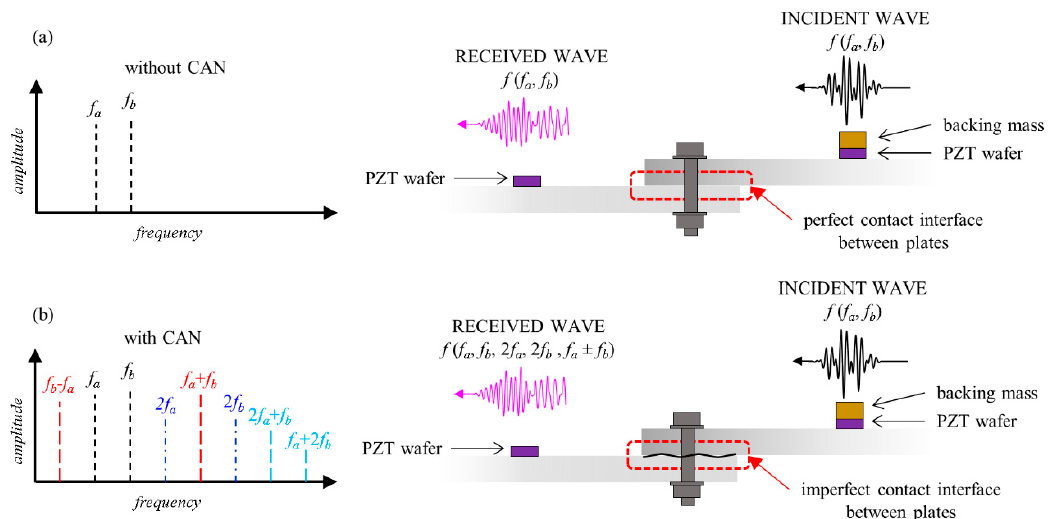
Figure 1. Contact acoustic nonlinearity phenomenon in the bolted joint with ( a ) perfect contact interface and ( b ) imperfect contact interface.